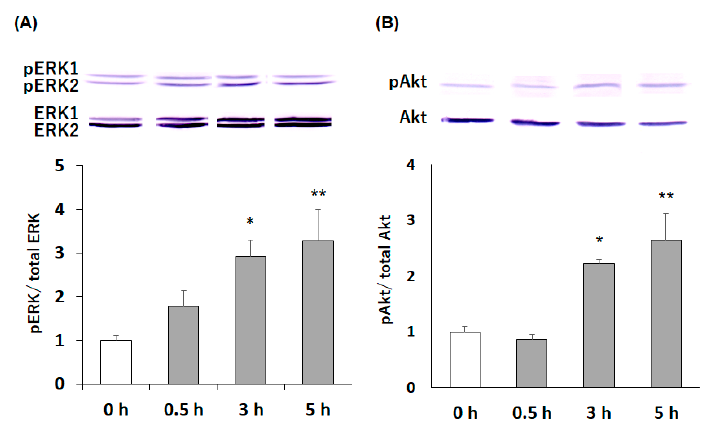
Figure 5. Effects of compound 13 on activation of extracellular signal-regulated kinases (ERK) 1/2 ( A ) and Akt ( B ) in neuro2a cells. Neuro2a cells were treated with 30 µM compound 13 for 0.5, 3 or 5 h; and then equal amounts of protein were analyzed by immunoblot analysis. The results represent the mean ± SEM ( n = 3, different culture). Significance difference in values between compound 13 -treated and non-treated (0 h) cells: * p < 0.05, ** p < 0.01 (one-way ANOVA followed by the Dunnett’s multiple comparison test).